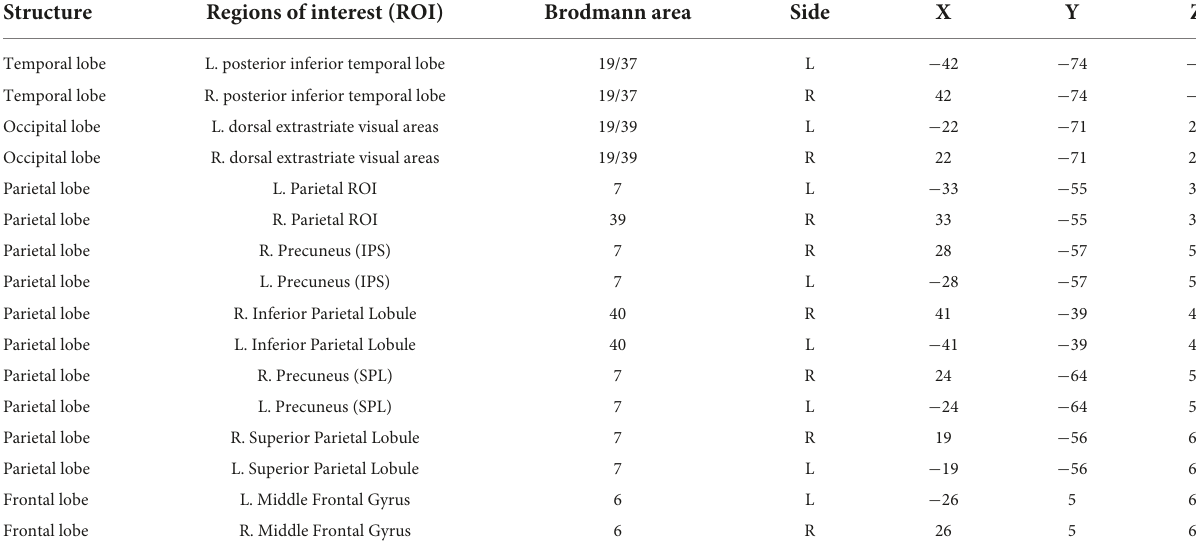
TABLE 1 Montreal Neurological Institute (MNI) coordinates of the centroid voxel for the frontal, parietal, temporal, and occipital lobes. Structure Regions of interest (ROI) Temporal